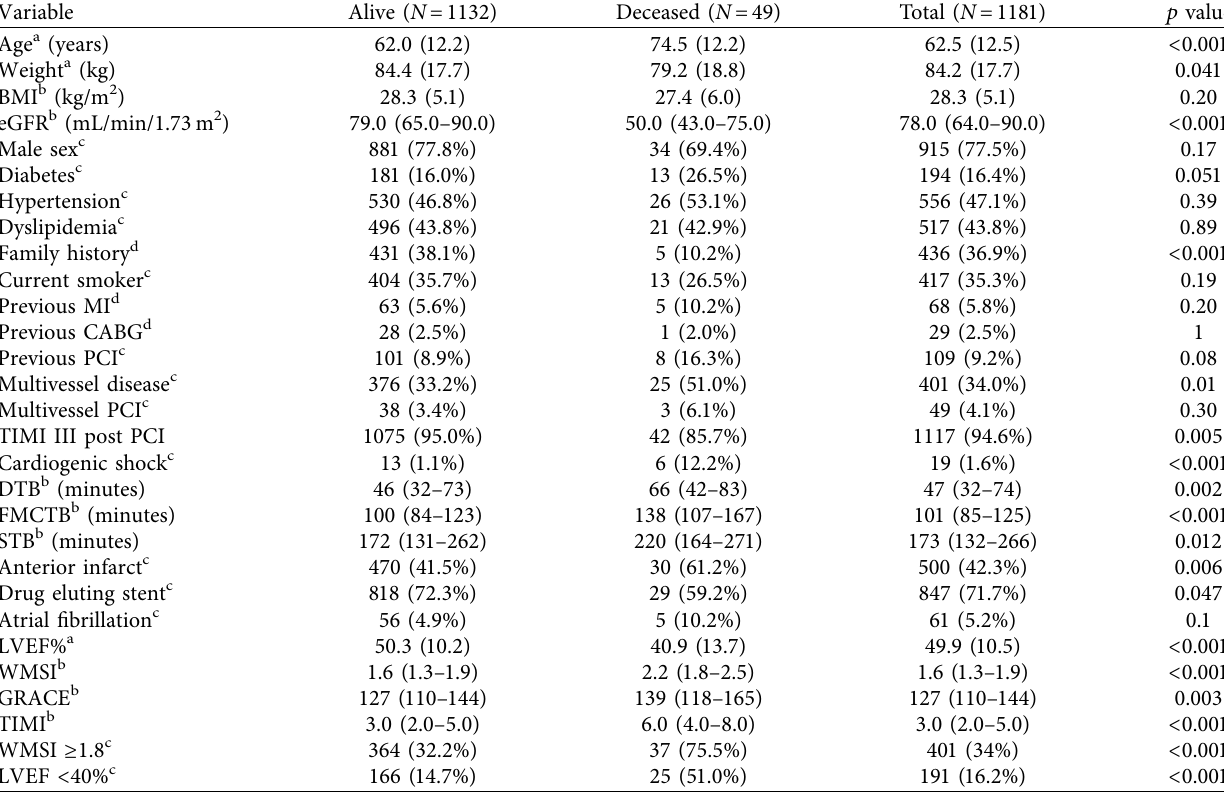
Table 1: Distribution of variables of interest by all-cause 12-month mortality following acute ST-segment elevation myocardial infarction (STEMI) treated with primary percutaneous intervention (PCI).